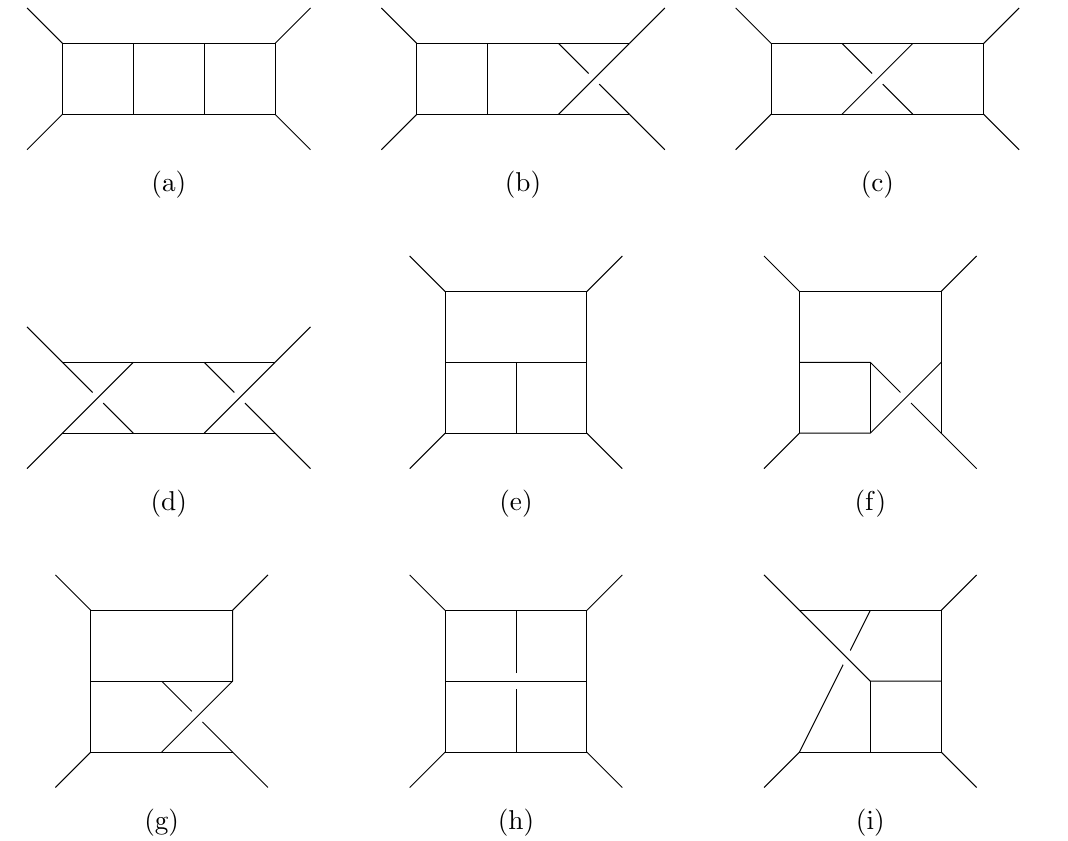
Figure 1 . The nine integral families needed to describe all master integrals for three-loop massless four-particle scattering. The external legs are associated with the momenta p 1 , p 3 , p 4 and p 2 in clockwise order starting with the top left